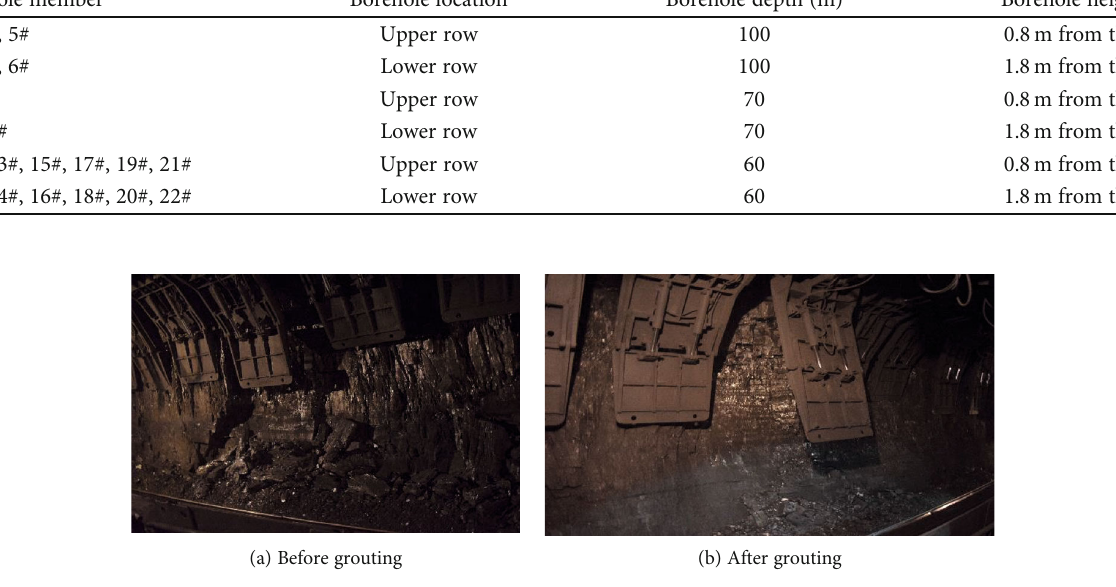
Figure 11: Rib sloughage status of the coal wall working face before and after grouting reinforcement.